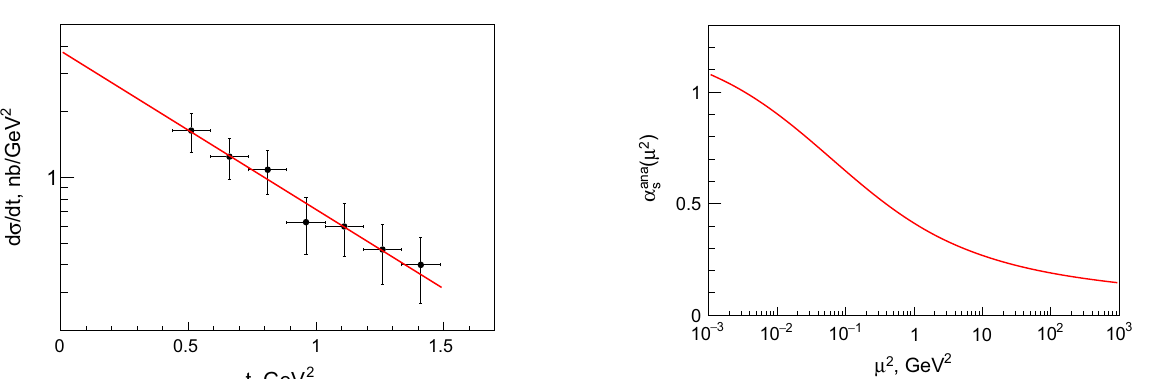
Fig. 1 The differential cross section of J /(cid:2) photo-production near threshold as measured by the GlueX Collaboration [22]. Only statistical uncertainties are shown